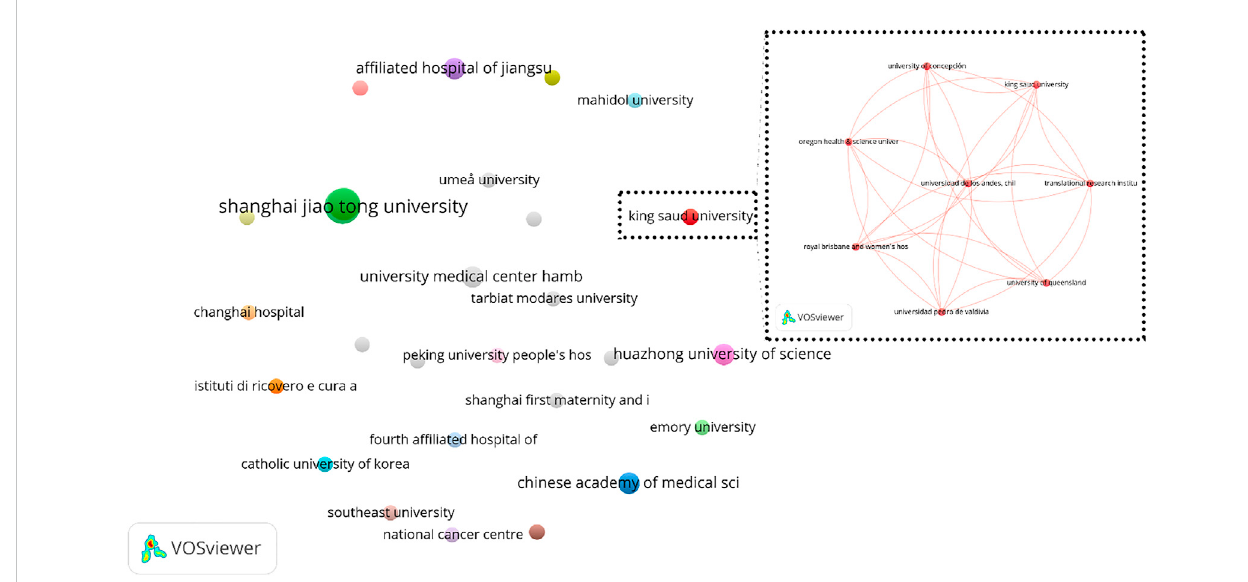
FIGURE 6 Organization co-authorship network (criteria: organizations with at least 1 article in the fi eld of exosome and OEC).